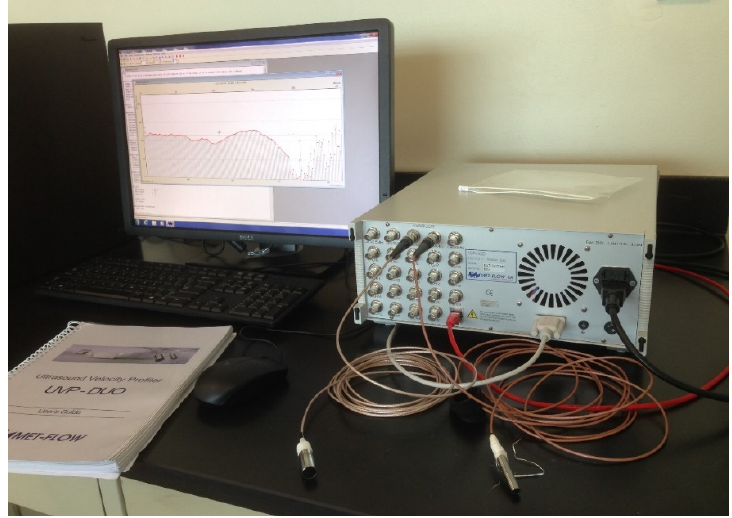
Figure 5. UVP machine from MET-FLOW.